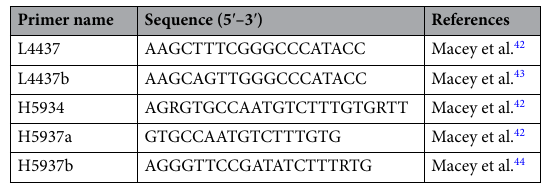
Table 1. Lists of primers used for PCR amplification and